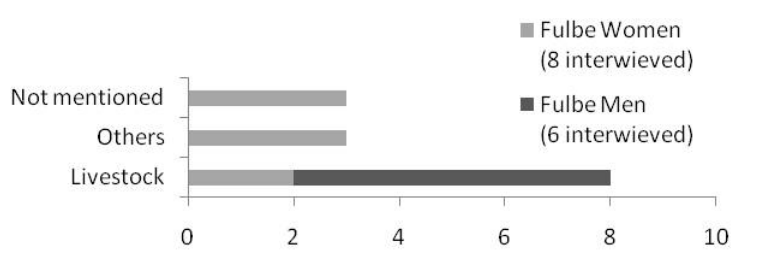
Fig A3.2: The interviewed Fulbes ranked SES functions according to their importance in their